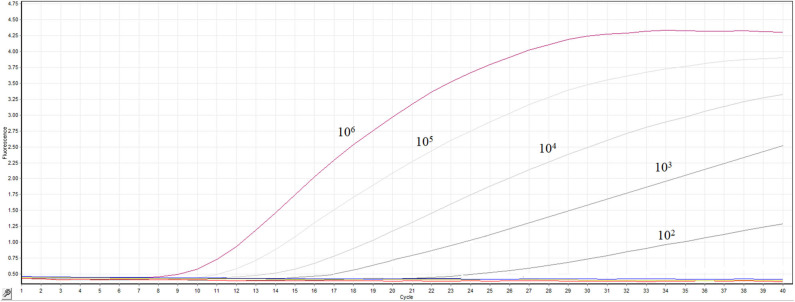
Sensitivity the real-time RT-RPA assay. A range of serially diluted RNA standards from 100 copy/μL-106 copies/μL were detected by the assay.